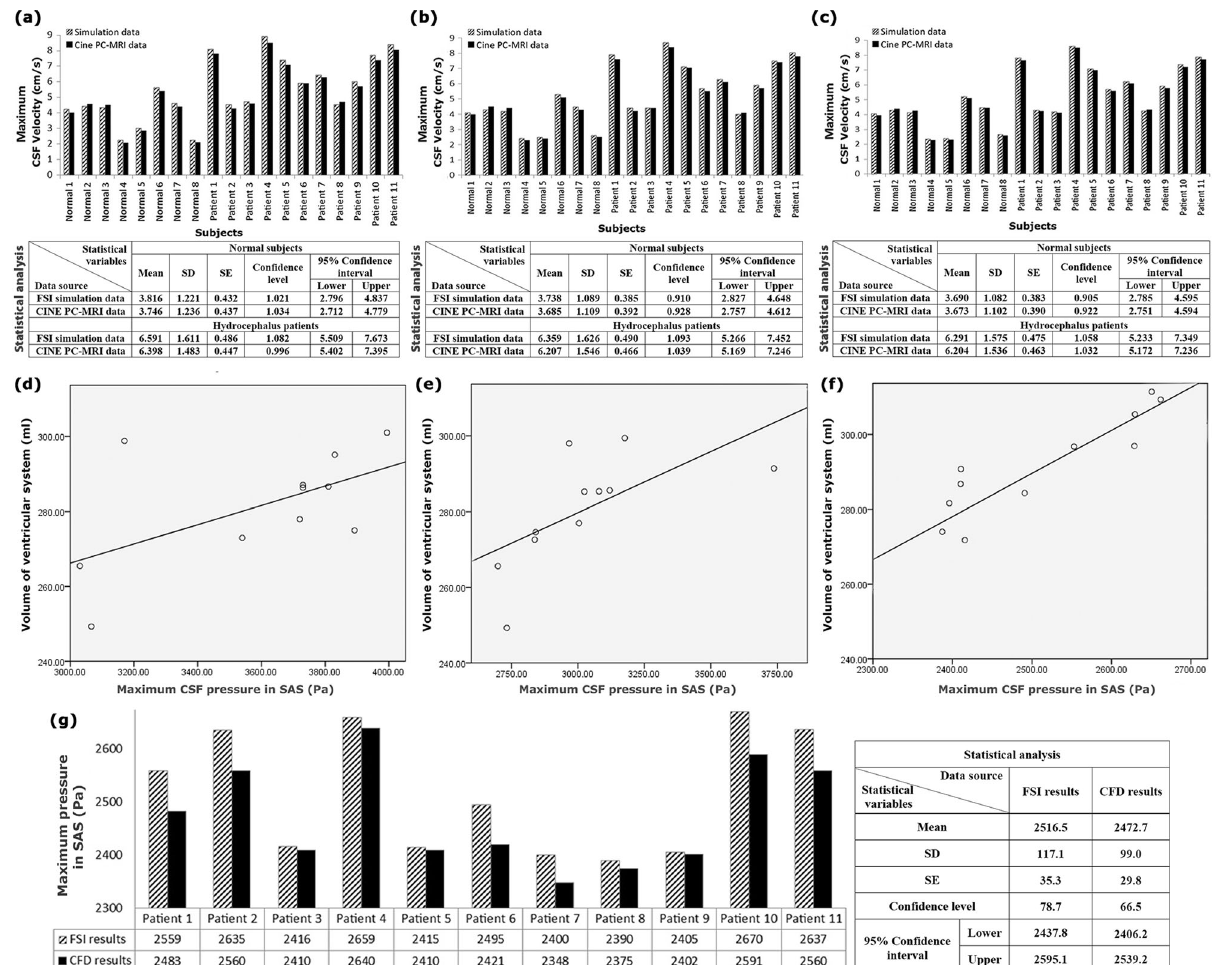
Fig. 3 Comparisons of the FSI simulation and CINE PC-MRI velocity data, FSI and CFD pressure data, and correlation results. a – c The comparison between the FSI simulation data and CINE PC-MRI data of the maximum CSF velocity in the CA of all healthy subjects and patients under BCs “ A ” , “ B ” , and “ C ” , respectively. d – f The PCC values between the maximum CSF pressure in SAS and the ventricular system volume of patients under BCs “ A ” , “ B ” , and “ C ” , respectively. g The comparison between the FSI and CFD data of the maximum CSF pressure in SAS of all the patients under BC “ C ” . It should be noted that there were 8 healthy subjects and 11 hydrocephalus patients in this study. Raw data for a – c are included in Supplementary Data fi le 2. Raw data for d – g are included in Tables 2 and 3. SE standard error, SD standard deviation, BC boundary condition, CSF cerebrospinal fl uid, CA cerebral aqueduct,